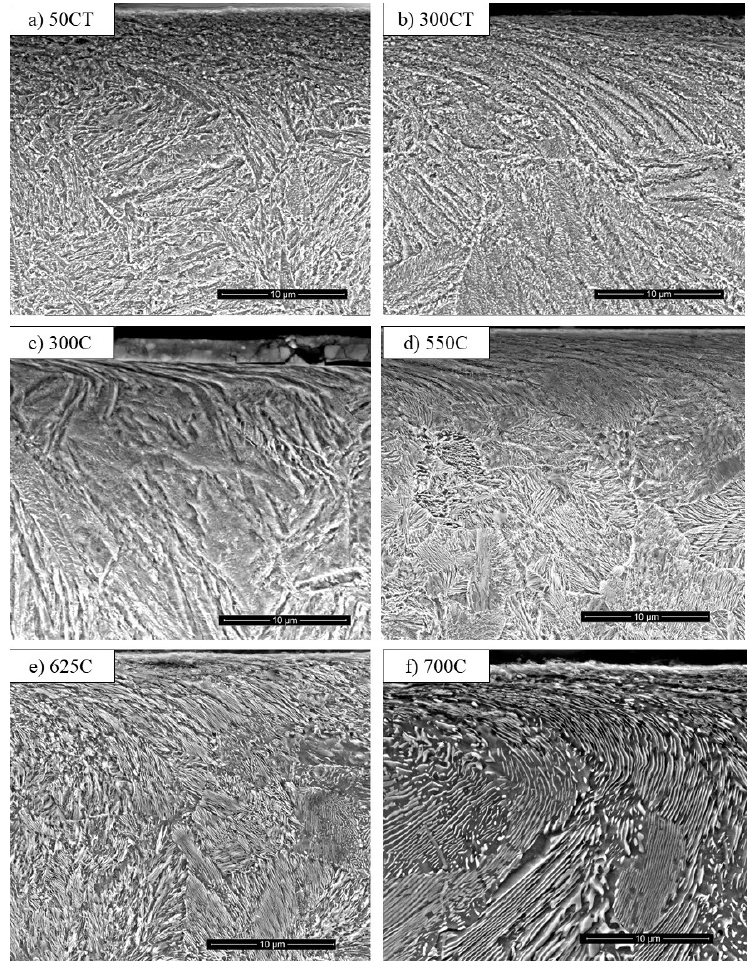
Figure 8. SEM micrographs of cross section pin